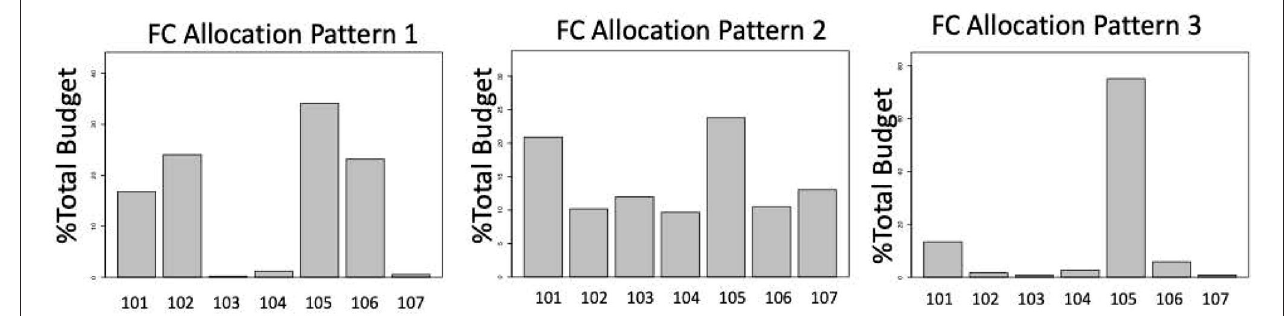
FIGURE 2 | FC allocation patterns from cluster analysis of percent FC Budget on FC capabilities. Fcap101: Emergency preparedness and Response, fcap102: Assessment, fcap103: Communication, fcap104: Community Partnership and Development, fcap105: Organizational Competency, fcap106: Policy Development and Support, fcap107: Other Capabilities.